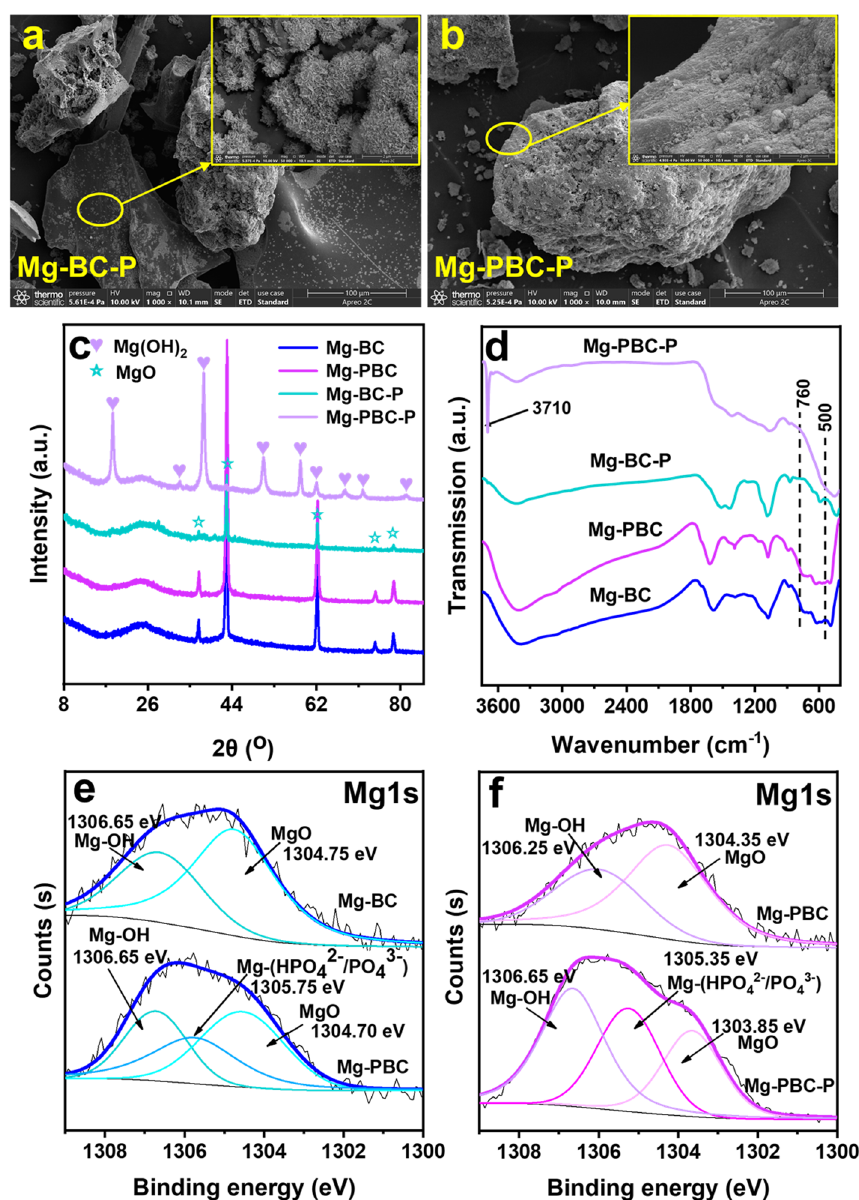
Fig. 6 SEM images of Mg-BC ( a ) and Mg-PBC ( b ) after P adsorptive recovery; X-ray diffraction patterns ( c ), FTIR spectrum ( d ) and the XPS spectrum ( e , f ) of Mg-BC and Mg-PBC before and after P adsorptive